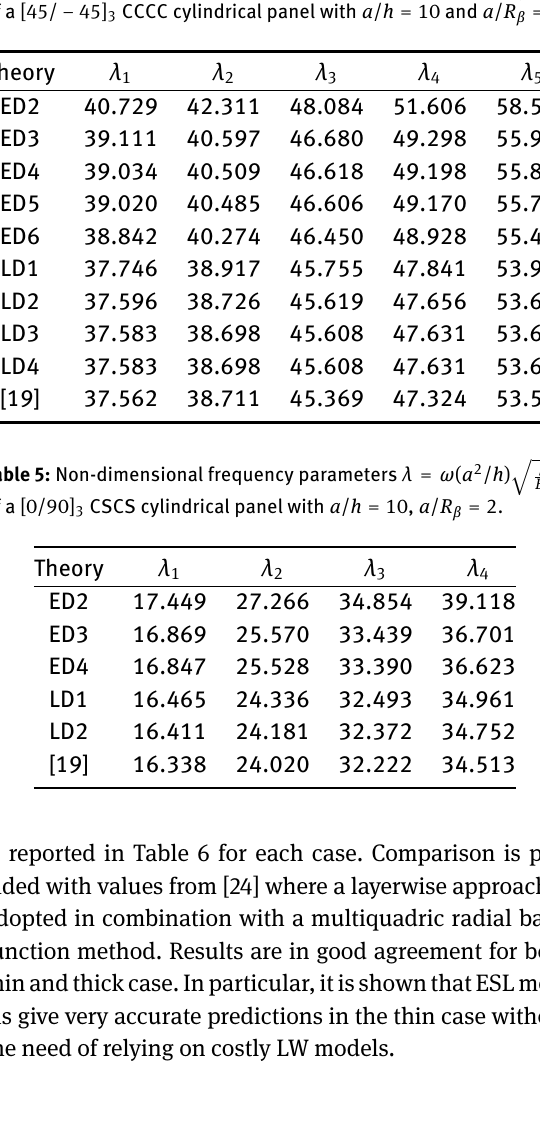
√︁ ρ of isotropic CCCC square spherical panels with a / R α = 0.5 . E a / h Theory